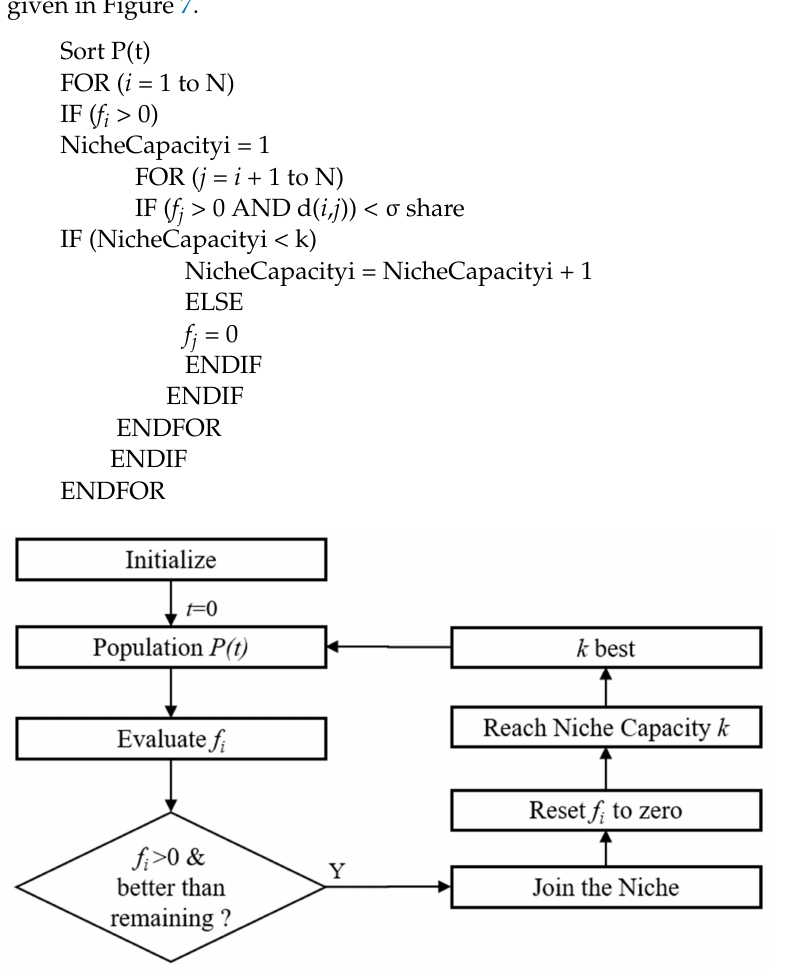
Figure 7. Clearing method procedure